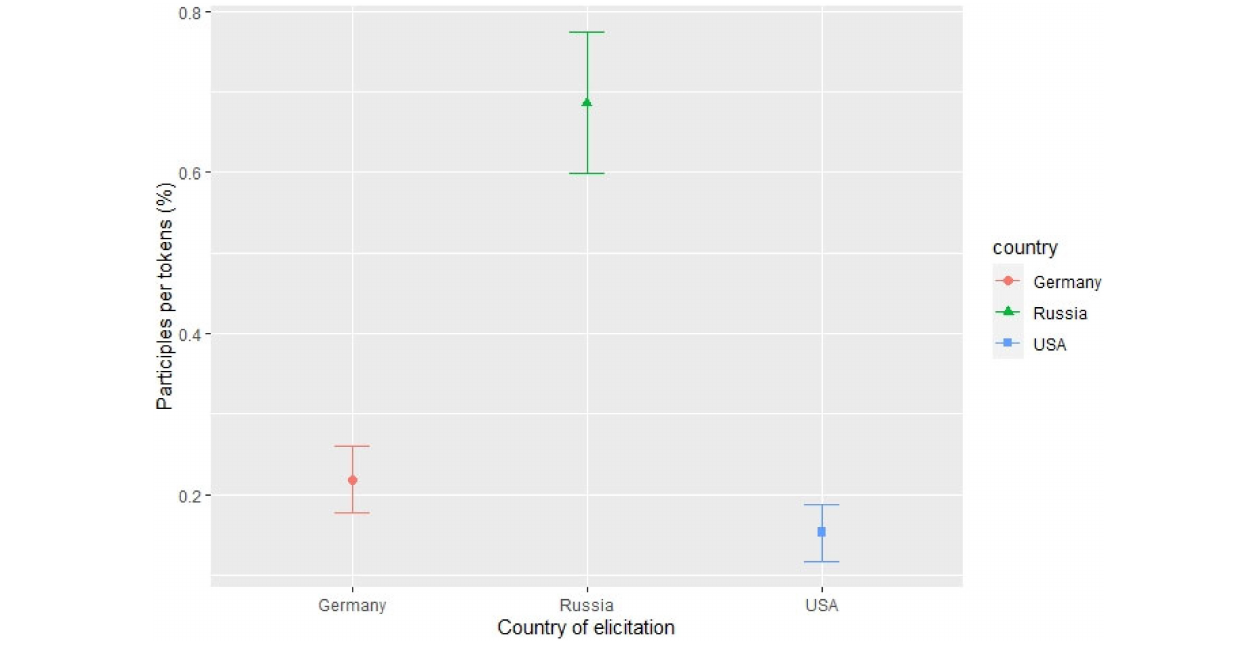
FIGURE 1 | Relative frequency of participles per tokens (%) across different